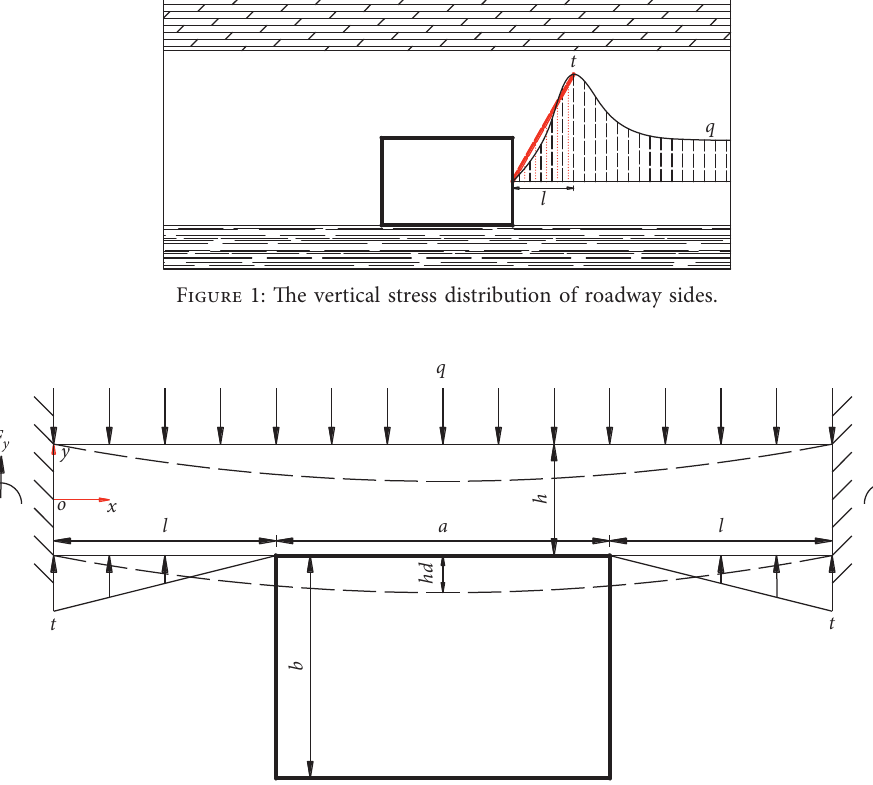
Figure 2: Mechanical model of roadway